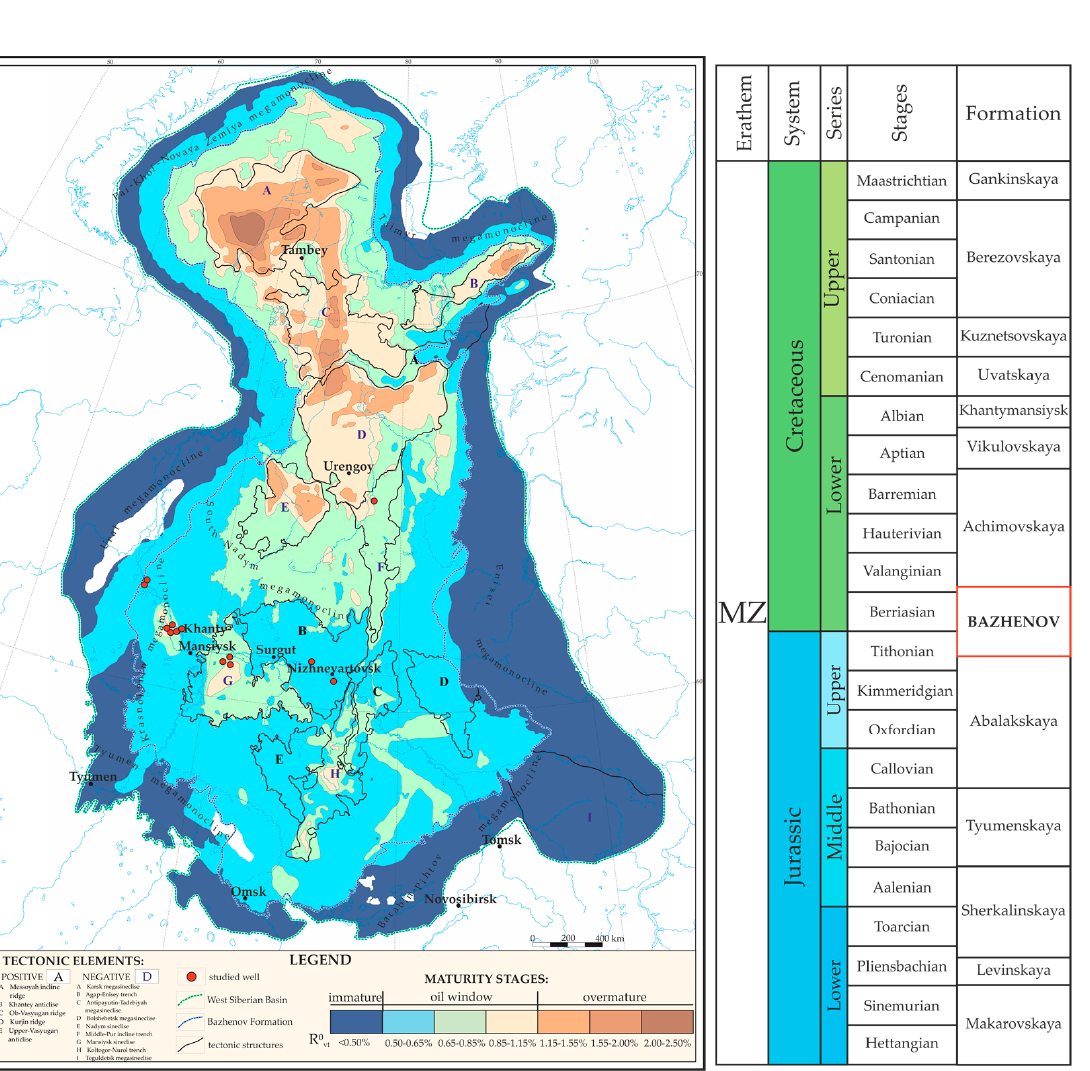
Figure 19. Box-plots for 4 productivity types. Uranium content, TOC, oil saturation, and productiv- ity indices are shown.